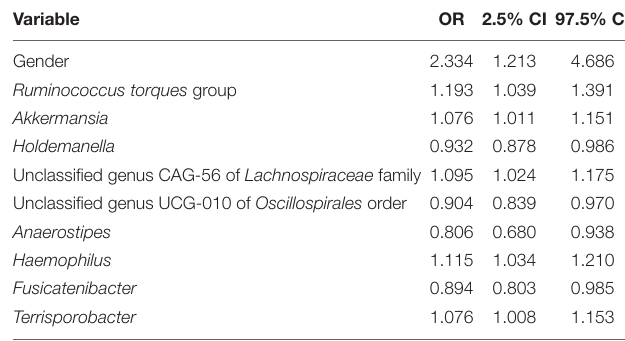
McFadden pseudo R 2 : 0.220, OR, odds ratio. TABLE 4 | Functional gastrointestinal disorders vs. non-FGID logistic model: demographics + genomics + microbiome (D + G + M).